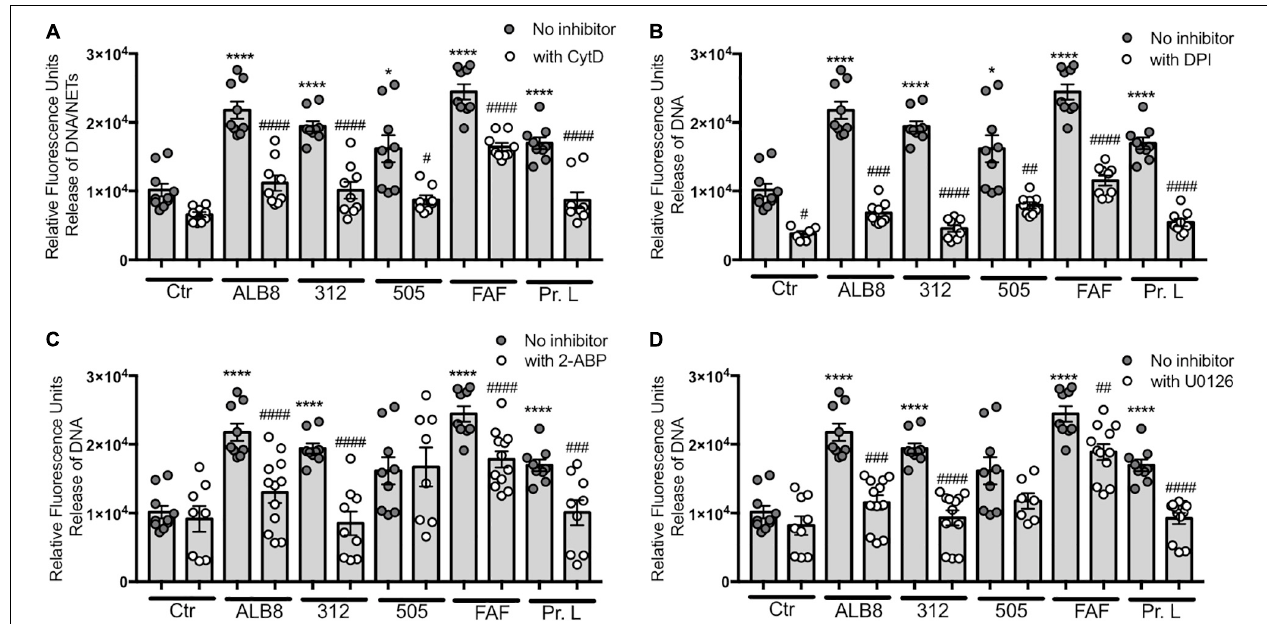
FIGURE 3 | Actin rearrangement and NADPH oxidases are involved in F. magna -mediated NET release. Neutrophils were co-incubated with heat inactivated F. magna bacteria or proteins FAF and L for 2 h. The release of NETs was blocked by the addition of (A) 20 µ M Cytochalasin D (CytD), (B) 10 µ M DPI, (C) 50 µ M 2-ABP, (D) 50 µ M U0126. All data represent mean ± SEM of 3–5 independent experiments. * p ≤ 0.05, **** p ≤ 0.0001 to Ctr; # p ≤ 0.05, ## p ≤ 0.01, ### p ≤ 0.001, #### p ≤ 0.0001 to stimuli without